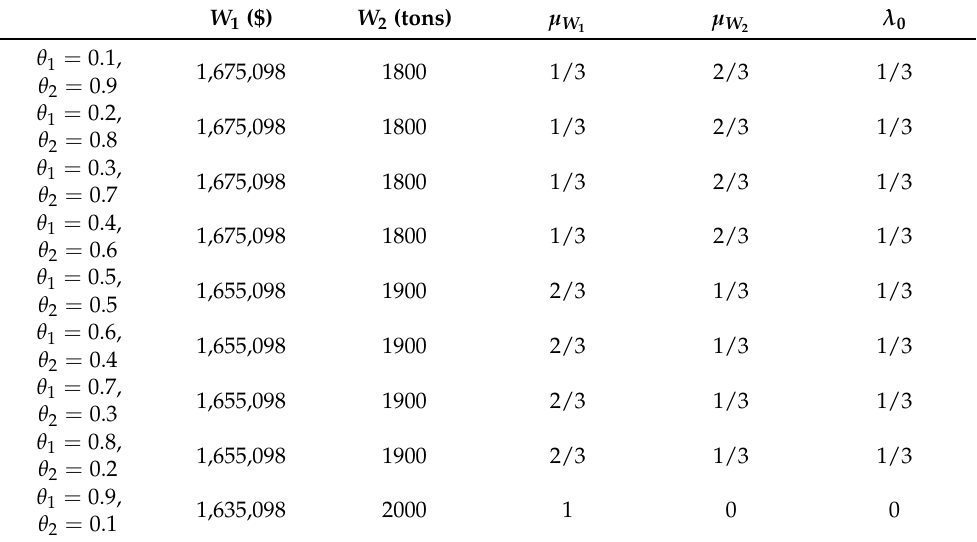
Table 3. Sensitivity analysis on the importance of objective functions ( θ 1 and θ 2